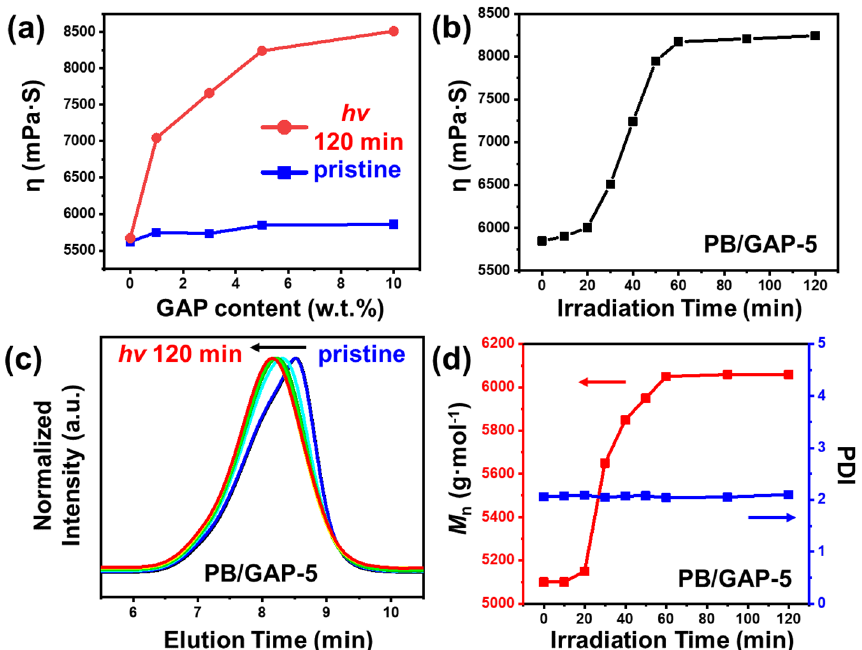
Figure 3. ( a ) Variation of the viscosity of PB/GAP blends before (blue) and after (red) 2 h of UV ‐ irradiation; ( b ) Variation of the viscosity of PB/GAP ‐ 5 blend with UV ‐ irradiation time; ( c ) GPC traces of the PB/GAP ‐ 5 blend after UV irradiation for different periods of time; ( d ) M n and PDI of the PB/GAP ‐ 5 blend after UV irradiation for different periods of time.